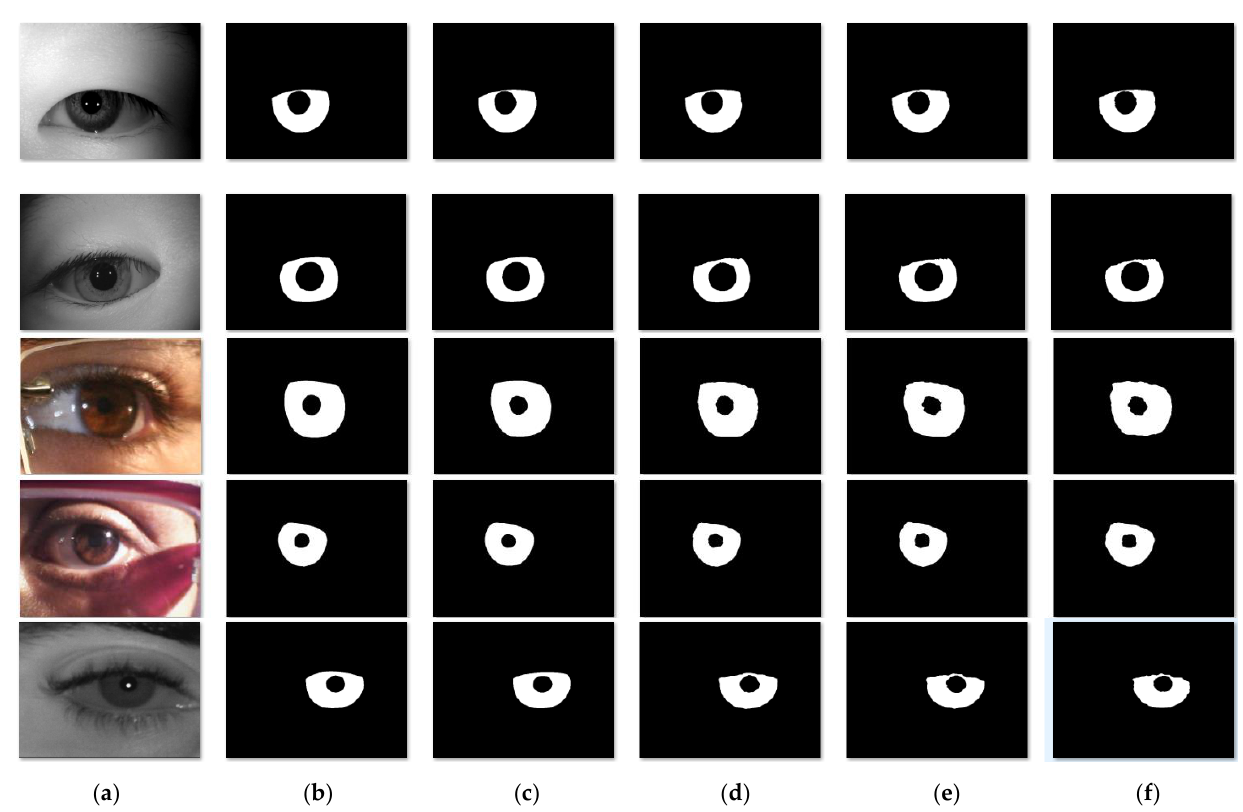
Figure 14. Test results comparison of PFSegIris and other three algorithms on five hard samples from JLU-7.0, CASIA-Iris- Lamp-v4, UBIRIS.V2, MICHE-I, and Mmu2, respectively: ( a ) original images; ( b ) ground truth; ( c ) segmentation results of PFSegIris; ( d ) segmentation results of MFFIris-Unet; ( e ) segmentation results of PI-Unet; ( f ) segmentation results of FRED- Net.